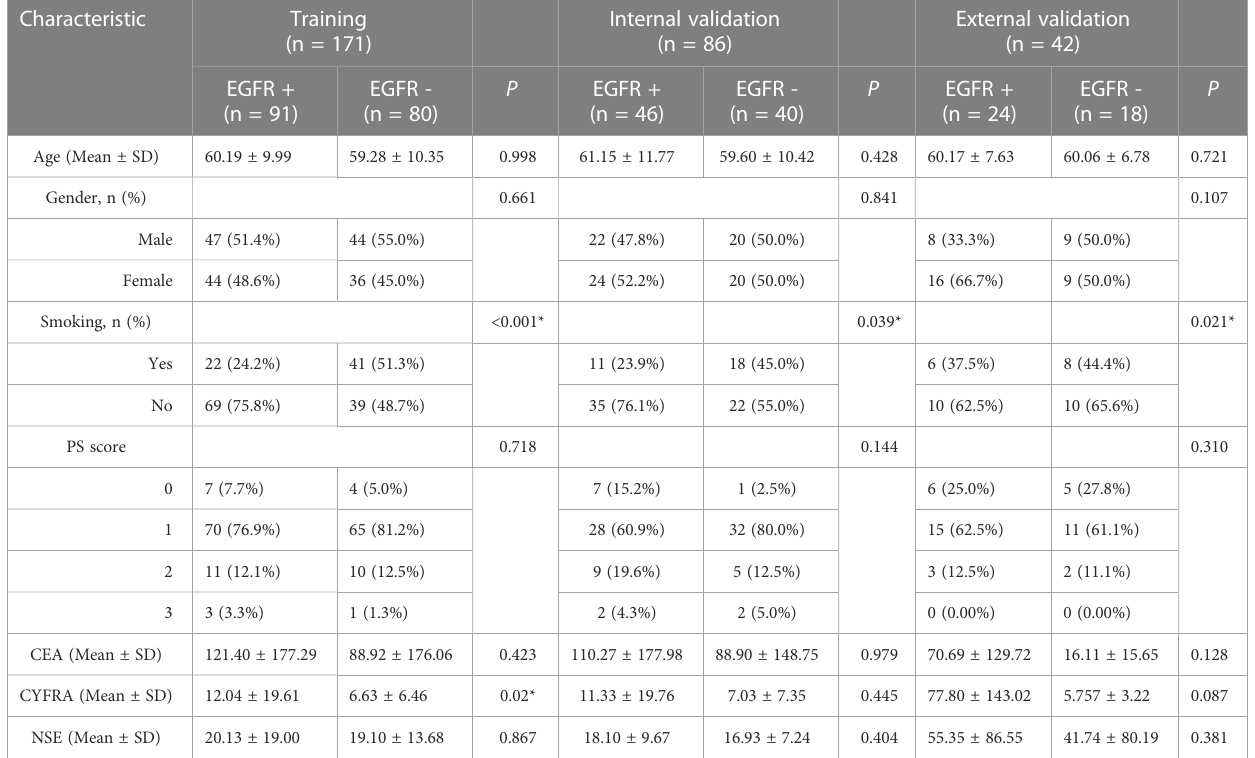
TABLE 1 Clinical characteristics of all patients in the training, internal validation and external validation